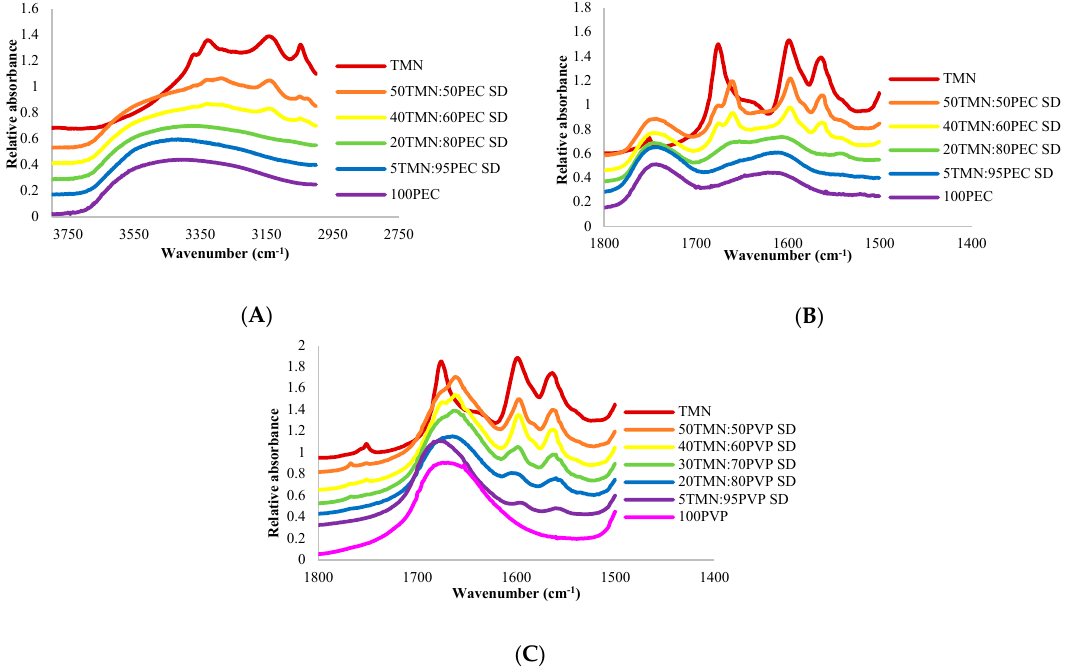
Figure 3. FTIR spectra of the ( A ) hydroxyl region of TMN:PEC solid dispersions, ( B ) carbonyl region of TMN:PEC solid dispersions, and ( C ) carbonyl region of TMN:PVP solid dispersions. The spectra are presented from top to bottom in decreasing order of TMN concentration.